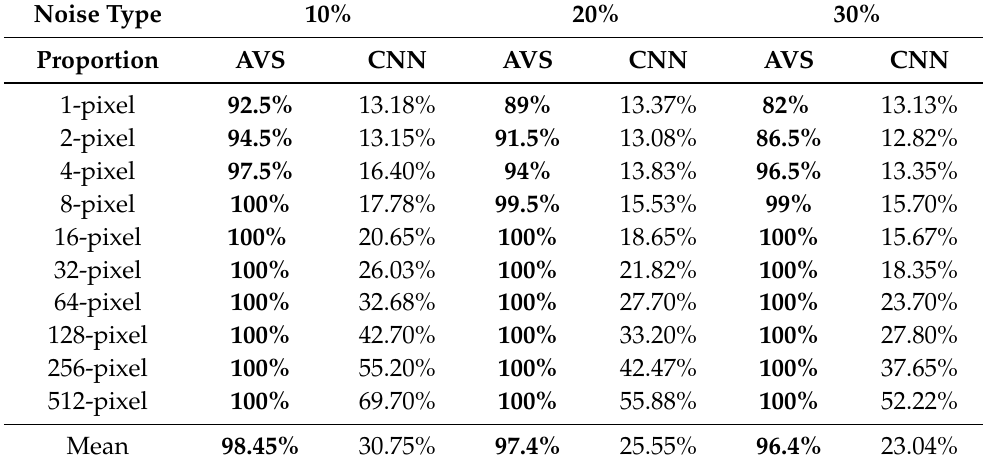
Table 3. The experimtental results of AVS and CNN under the static background